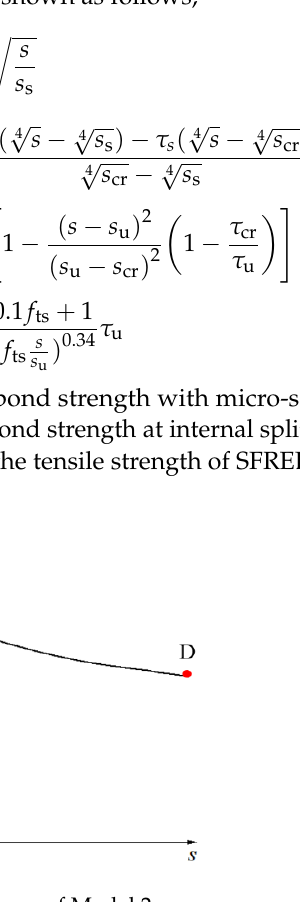
Figure 11. Bond stress-slip curve of Model 2.